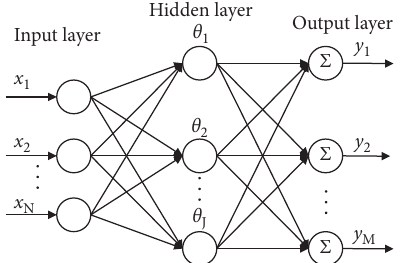
Figure 1: The RFB neural network structure diagram.